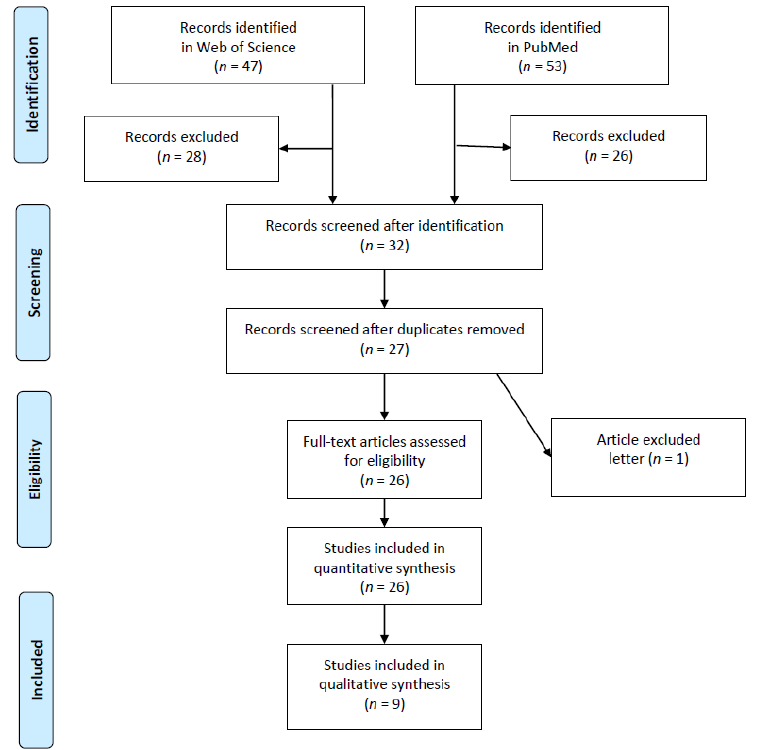
Figure 1. Literature research on rescue blankets and emergency medicine (PRISMA).